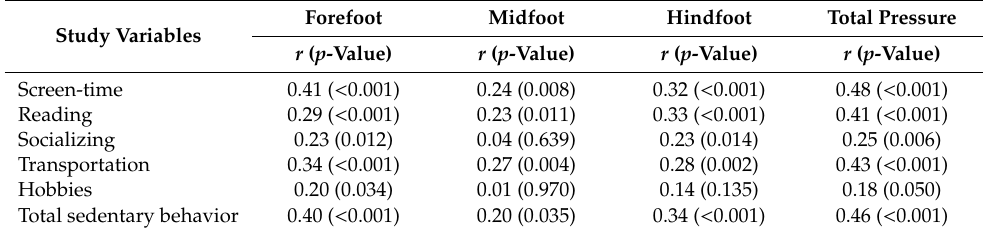
Table 3. Adjusted * correlations between sedentary behavior domains and total sedentary behavior with peak plantar pressures ( n =